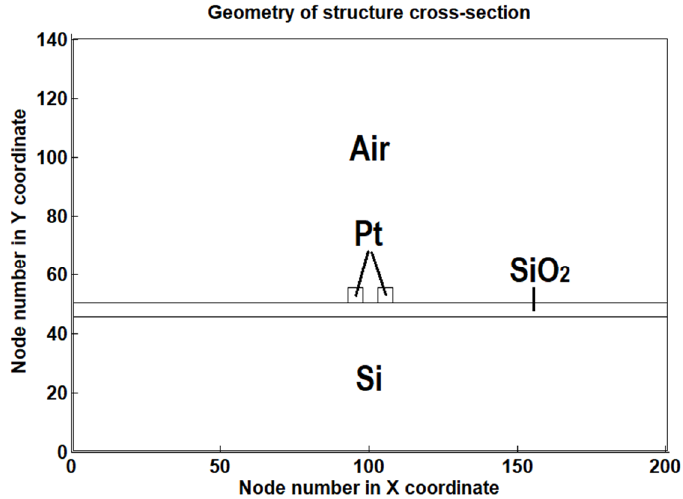
Figure 1. Geometry of cross-sectional area of the investigated test structure.